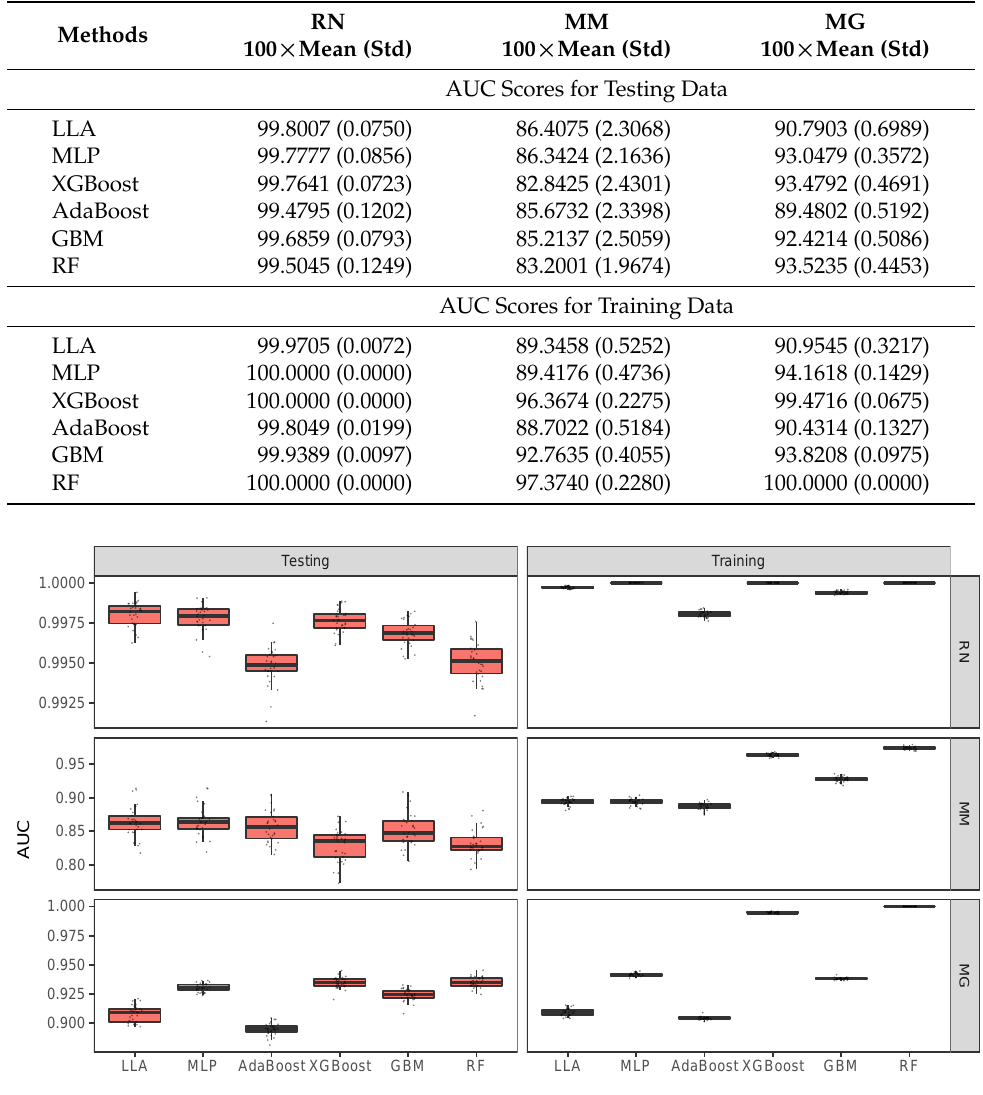
Table 3. Comparison with commonly-used classifiers with default hyper-parameters value.